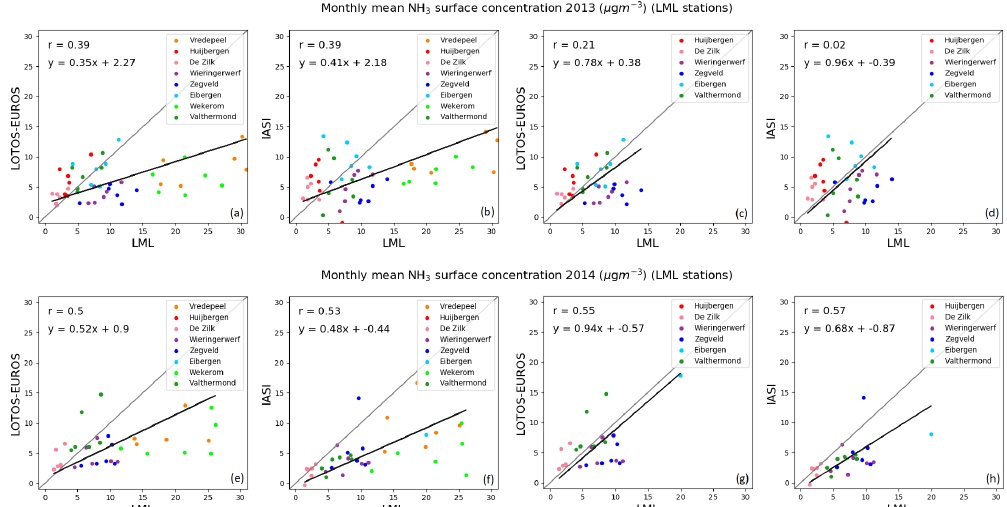
Figure 7. Comparison of the monthly mean NH 3 surface concentrations measured by the LML stations and the corresponding LOTOS- EUROS and IASI-derived NH 3 surface concentrations during the warm season (April–September) of 2013 (top) and 2014 (bottom). The high-concentration stations (Vredepeel and Wekerom) are eliminated from the right figures (c, d, g, h) . Table 3. Month-by-month comparison of the correlation coefficient ( r ), slope and intercept of the monthly mean NH 3 surface concentrations of the LML stations ( x axis) and the coinciding monthly mean LOTOS-EUROS and IASI-derived NH 3 surface concentrations ( y axis). The arrows denote which of the two (LOTOS-EUROS or IASI) gives the most desirable value. The arrows are attributed to either LOTOS-EUROS or IASI based on the following criteria: highest r , slope closest to 1, intercept closest to 0 and smallest RMSD. LOTOS-EUROS IASI-derived Month r